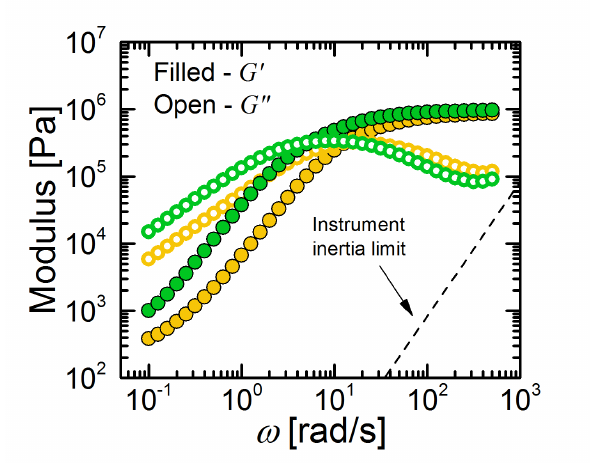
Figure A3: Small amplitude oscillatory shear experiments for the soft (yellow) and firm (green) putties with an input stress amplitude of σ 0 = 100 Pa. Filled symbols represent the elastic or storage modulus G ′ ; open symbols represent the viscous or loss modulus G ′′